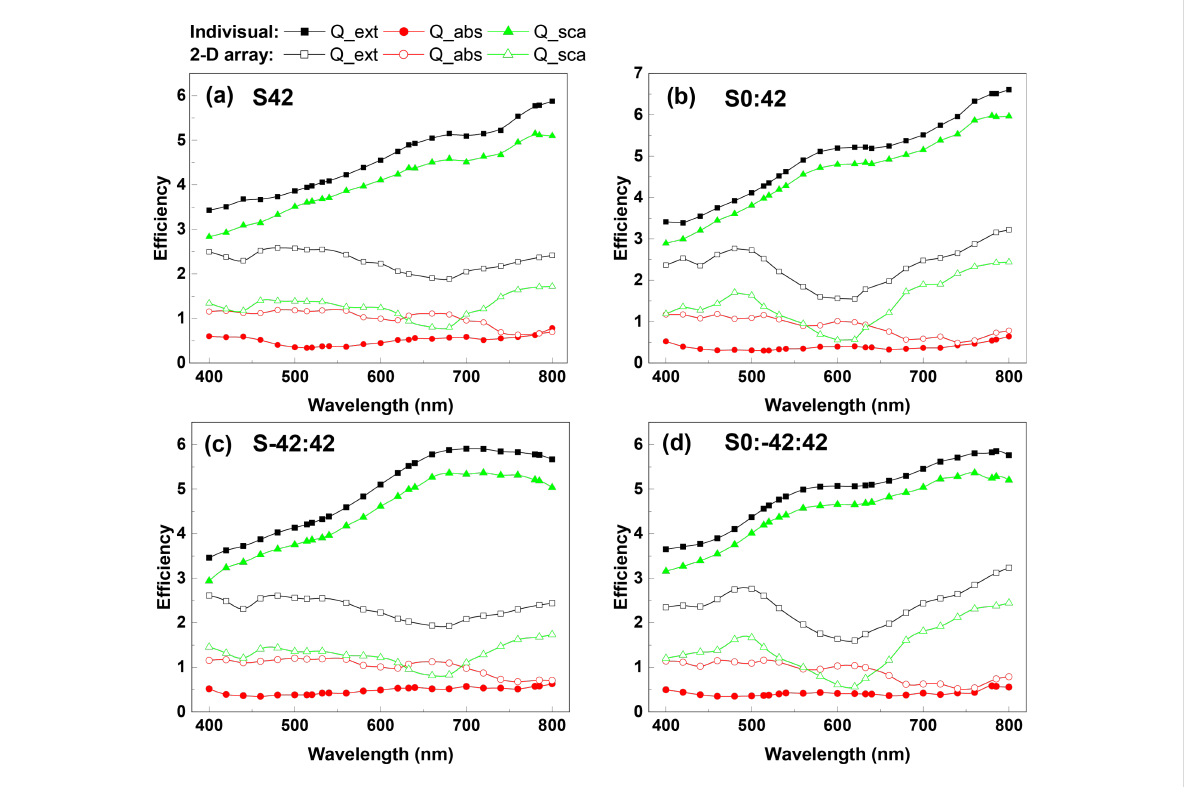
Figure 3: Extinction, absorption and scattering efficiencies of the four target units with AR = 3.5 and their 2D hexagonal arrays with a periodicity of 300 nm: (a) S42, (b) S0:42, (c) S − 42:42, (d) S0: − 42:42. The light is incident along the substrate surface normal with p-polarization.